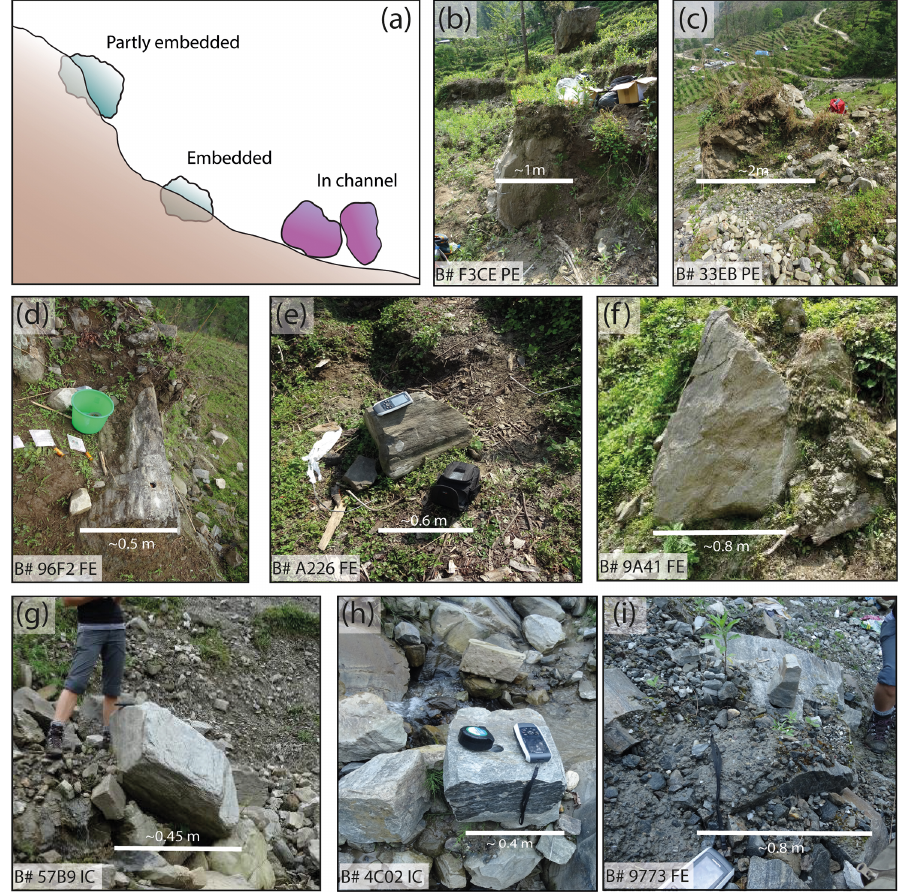
Figure 3. (a) Sketch of boulder position types. (b–c) Examples of partly embedded (PE) boulders within the landslide body. (d–f) Examples of fully embedded (FE) boulders within the landslide body. (g–h) Examples of boulders inside the main channel (IC). (i) Example of a fully embedded (FE) boulder within the channel